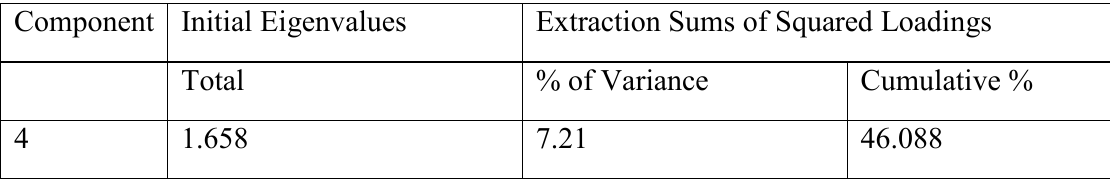
Table 1.45: Variance explained for Transformative Resilience PC4 Component